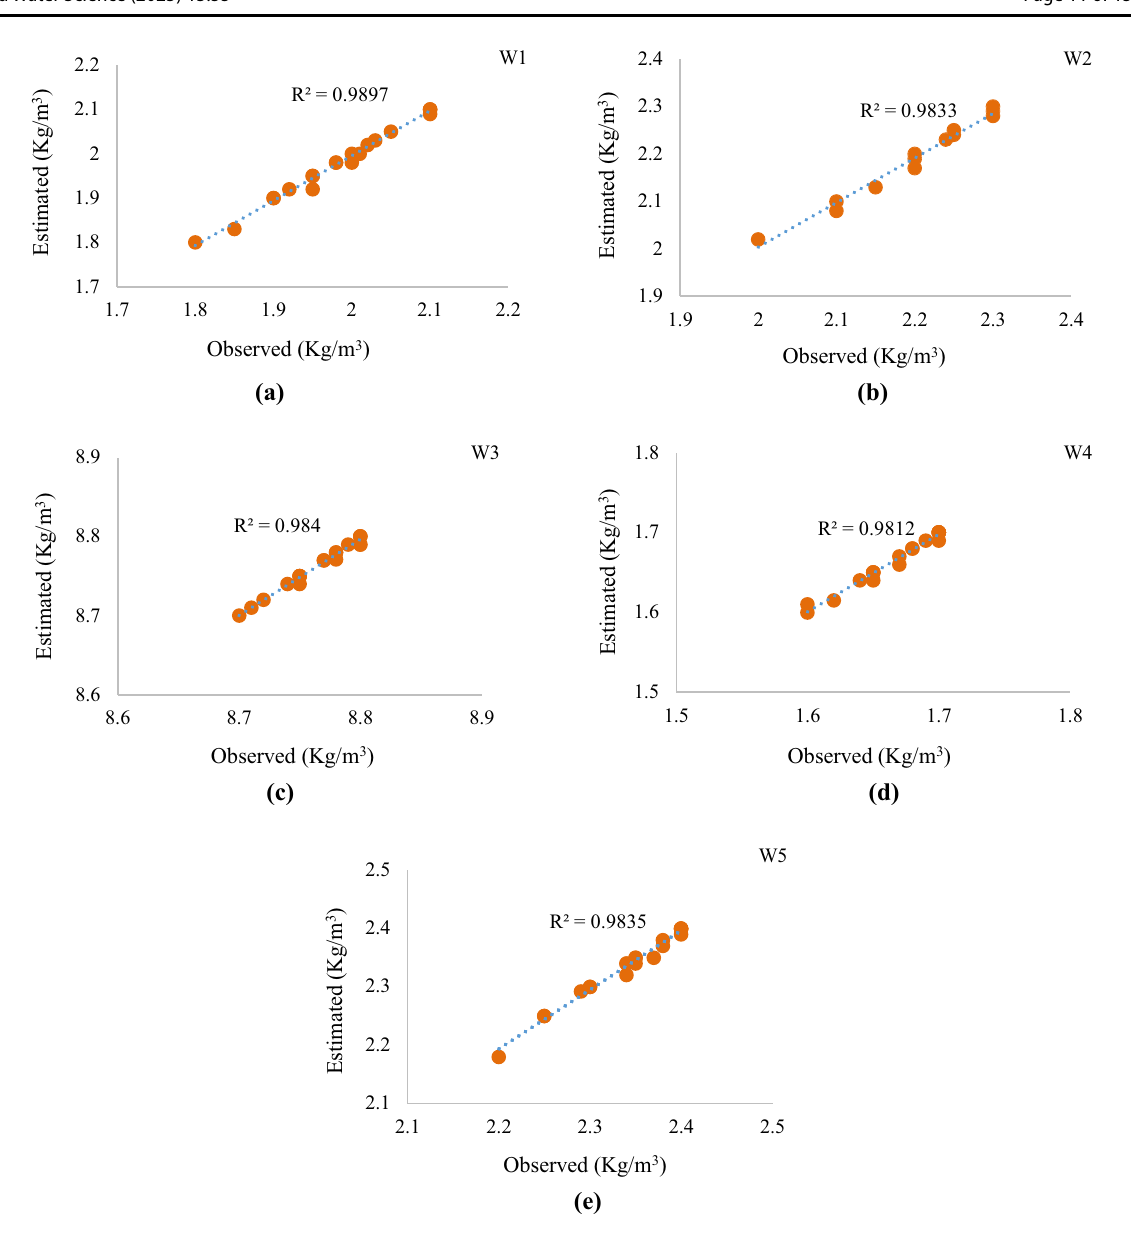
Fig. 7 (a, b, c, d) Comparison of measured and estimated